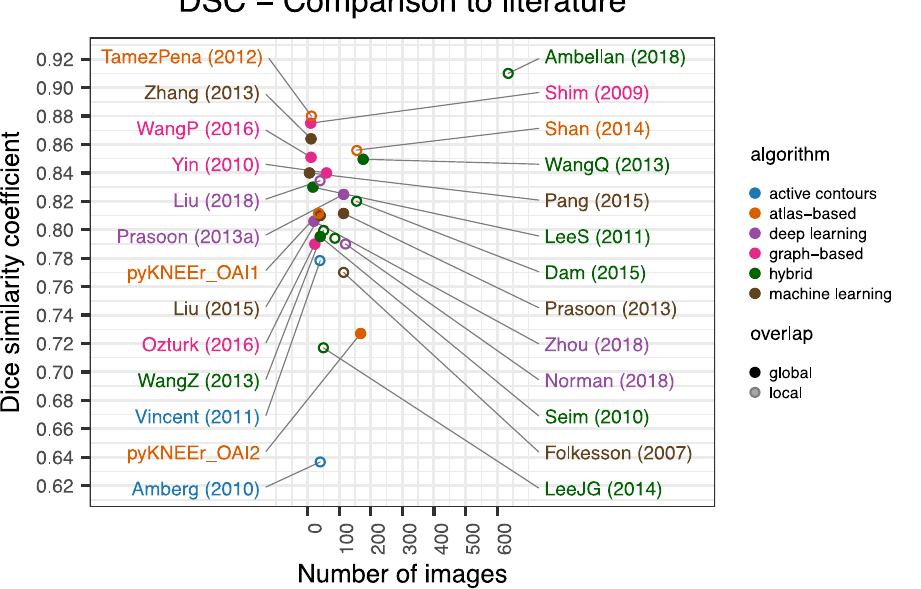
Fig 5. Performances of the segmentation module of pyKNEEr , compared with 24 studies in literature that report it. Full dots represents studies where DSCs were calculated on the whole mask, whereas empty dots represent studies where DSCs were calculated in specific parts of the cartilage, e.g. the weight-bearing area [28]. (See data, code, executable